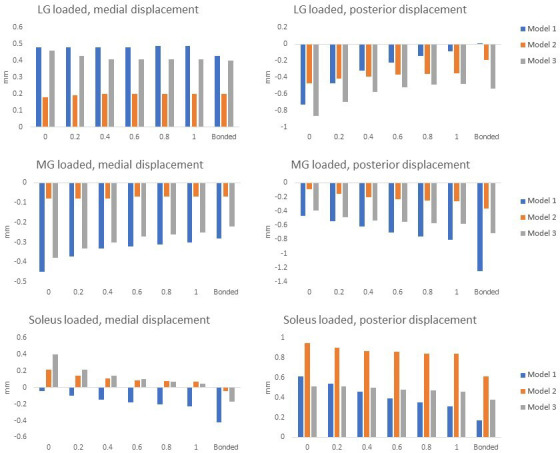
Mean transverse plane displacements (in mm) of the proximal soleus face of the three models with different friction contacts (x-axes) when each sub-tendon was loaded in isolation.Large variations in displacements and directions were noted between different models under different loading conditions. The scale of the y-axes differs to allow better visualisation of differences in the data.